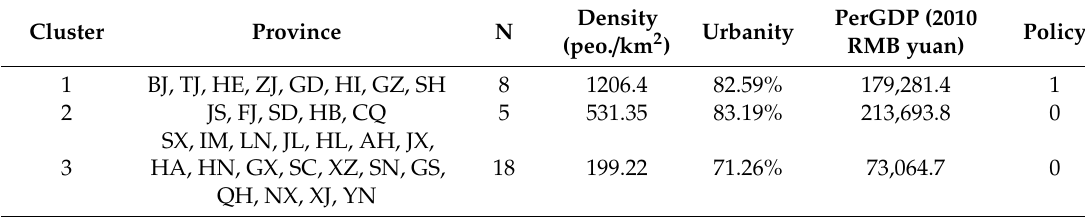
Table 8. Summary of